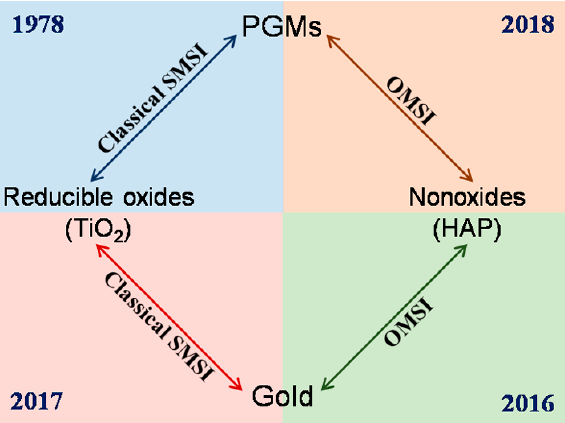
Figure 10. Schematic illustration of the catalyst systems for classical SMSI and OMSI. Contemporaneous with the discovery of the classical SMSI effect in Au/TiO 2 , a